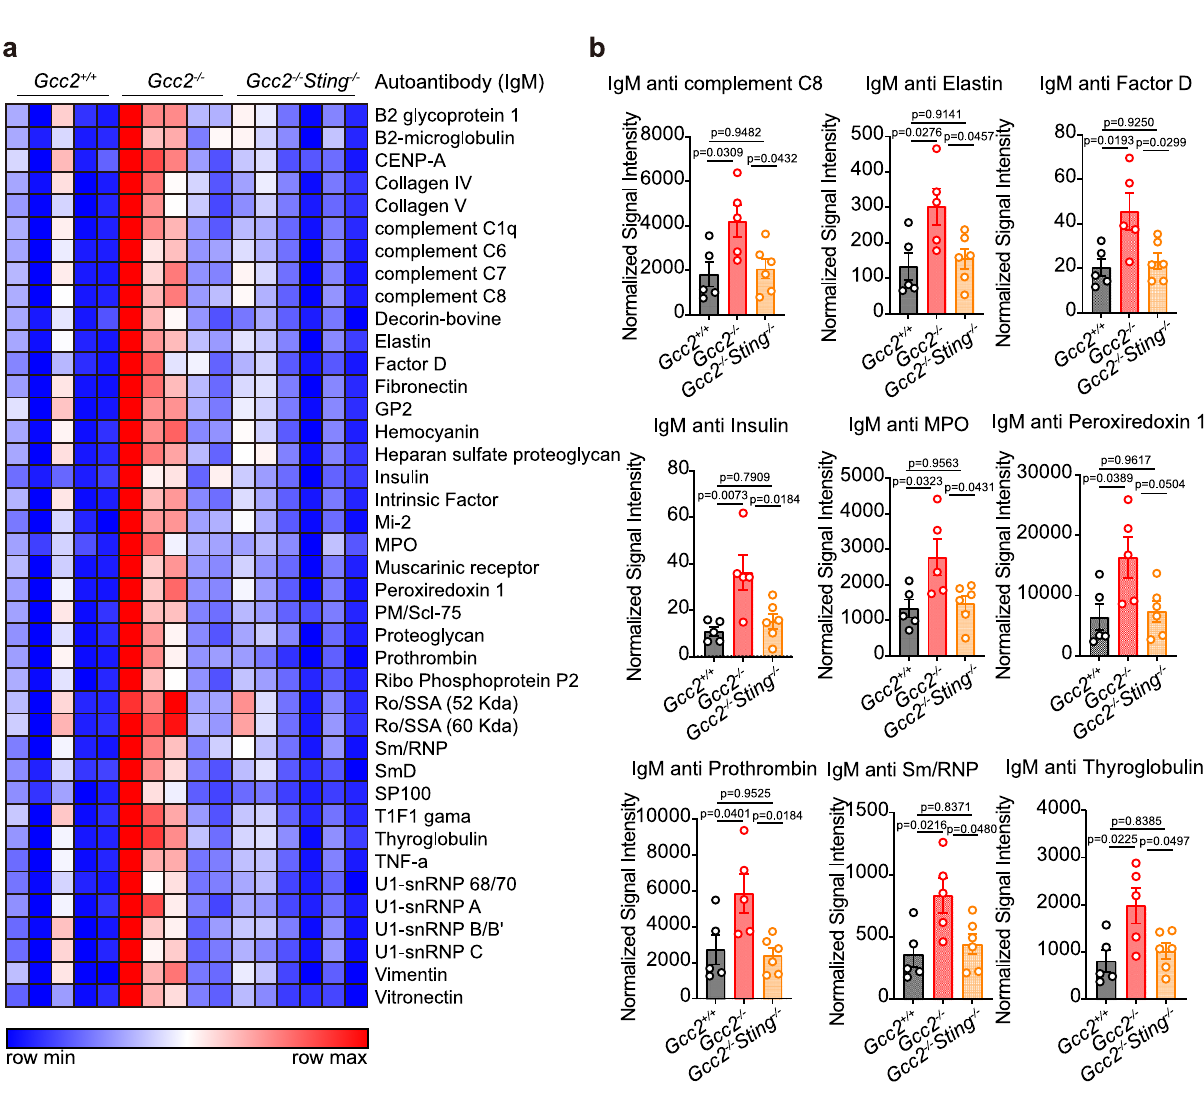
Fig. 7 | Gcc2 − / − mice develop STING-dependent serologic autoimmunity. a A heatmap showing IgM autoantibody array analysis of Gcc2 +/+ , Gcc2 − / − , and Gcc2 − / − Sting − / − mouse serum (6-month-old).n=5. b Representative bar graphs ofelevated